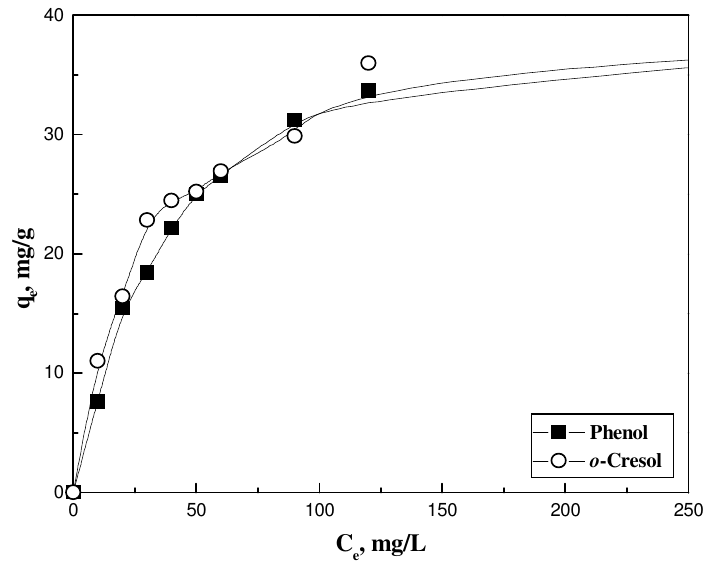
Figure 3. Kinetic curves for adsorption of phenols on CC Table 4. Pseudo-second order parameters for the adsorption of phenols on CC Equilibrium uptake,